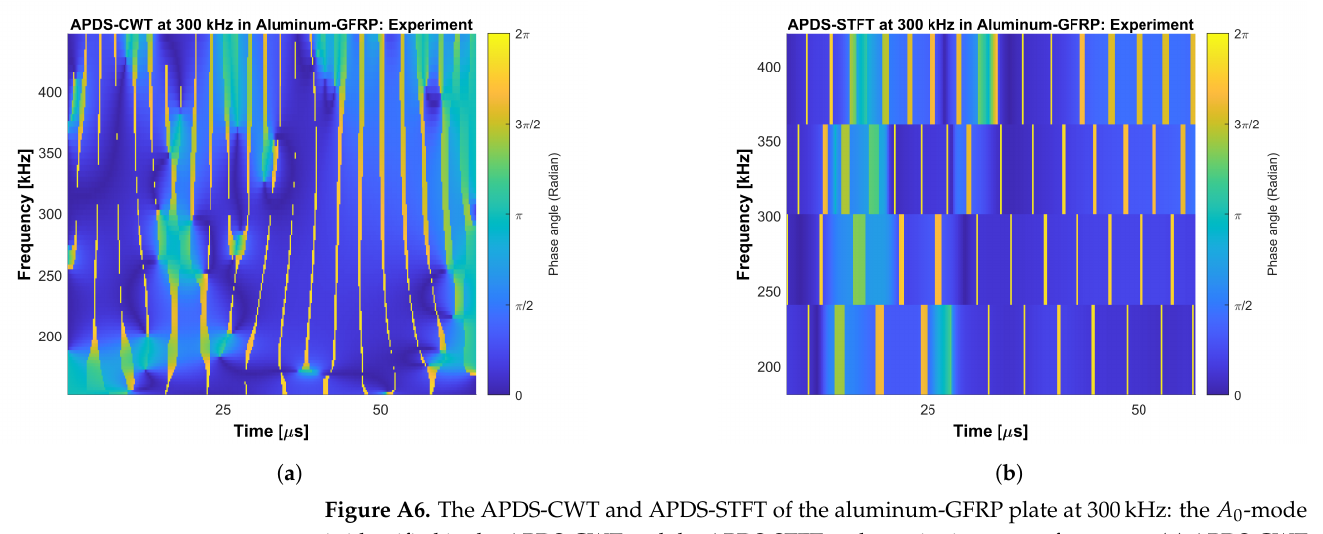
Figure A6. The APDS-CWT and APDS-STFT of the aluminum-GFRP plate at 300kHz: the A 0 -mode is identified in the APDS-CWT and the APDS-STFT at the excitation center frequency. ( a ) APDS-CWT of the aluminum-GFRP plate at 300kHz. ( b ) APDS-STFT of the Aluminum-GFRP plate at